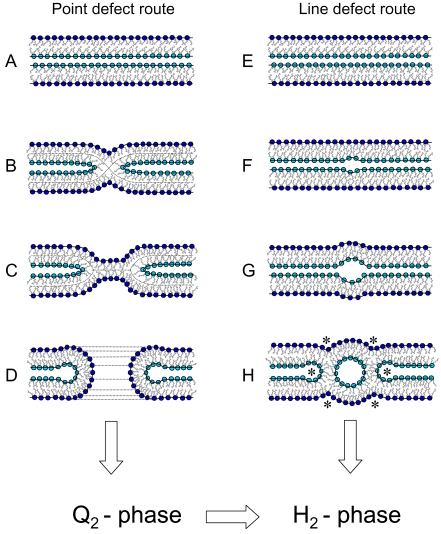
Two schematics of the proposed pathways from the bilayer to the inverted monolayer tube transition.On the left hand side, the classical vesicle fusion route is depicted. The formation of pores is widely believed to be the prerequisite for the formation of bicontinuous cubic (Q2) nanostructures [87], which upon further curvature frustration may transform into self-assembled monolayer tubes (H2 phase). On the right hand side, the direct formation of an inverse lipid nanotube between two opposed bilayers is illustrated. For better understanding of the structural conversions, the headgroups of opposed monolayers are shown in light blue whereas the rest are depicted in blue (for further details see text).